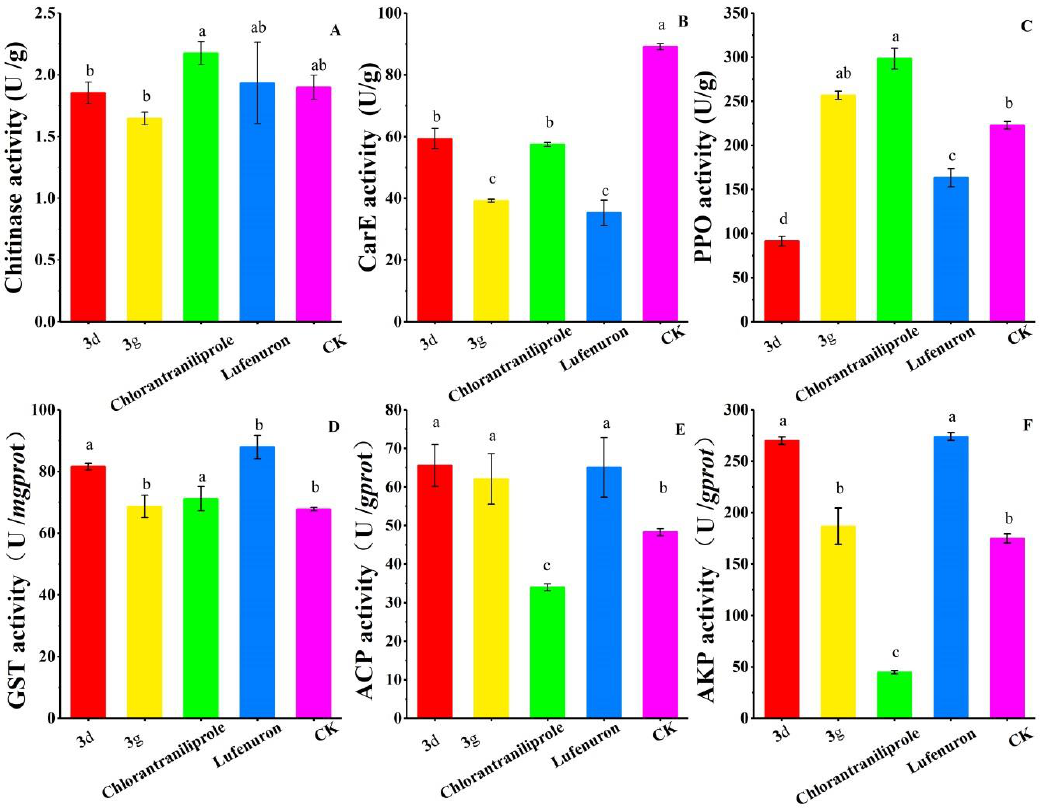
Figure 2. Effect on H. armigera (Hübner) enzyme activity by tschimganin analogs. ( A ) Chitinase activity; ( B ) CarE activity; ( C ) PPO activity; ( D ) GST activity; ( E ) ACP activity; ( F ) AKP activity. a–c ( p < 0.05; Duncan’s test).